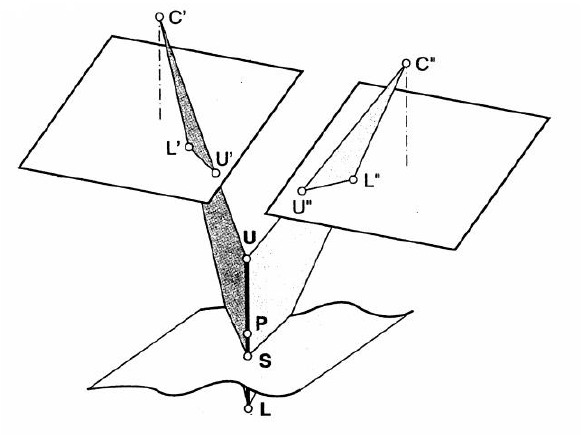
Figure 5. The principle of vertical line locus (Schenk, 1999). Searching along VLL is not suitable for terrestrial MMS image